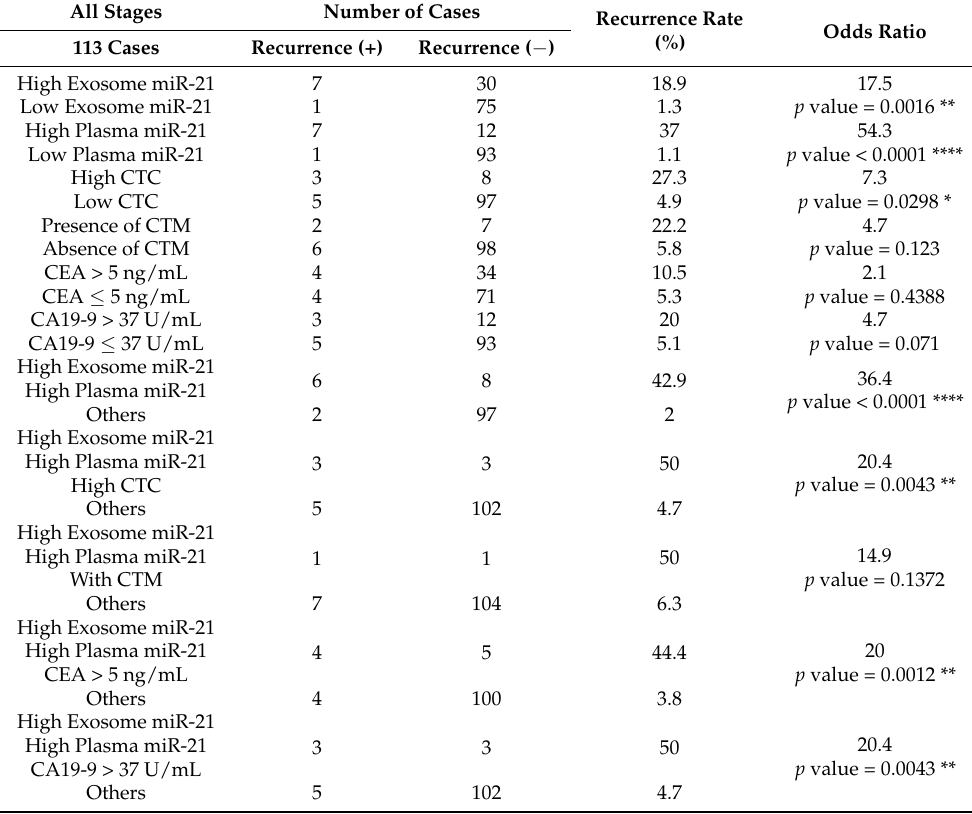
Table 2. Recurrence rate and odds ratios (ORs) of several biomarkers individually and combined to predict CRC recurrence in 113 patients in all stages (* p < 0.05; ** p < 0.01; **** p < 0.0001). All